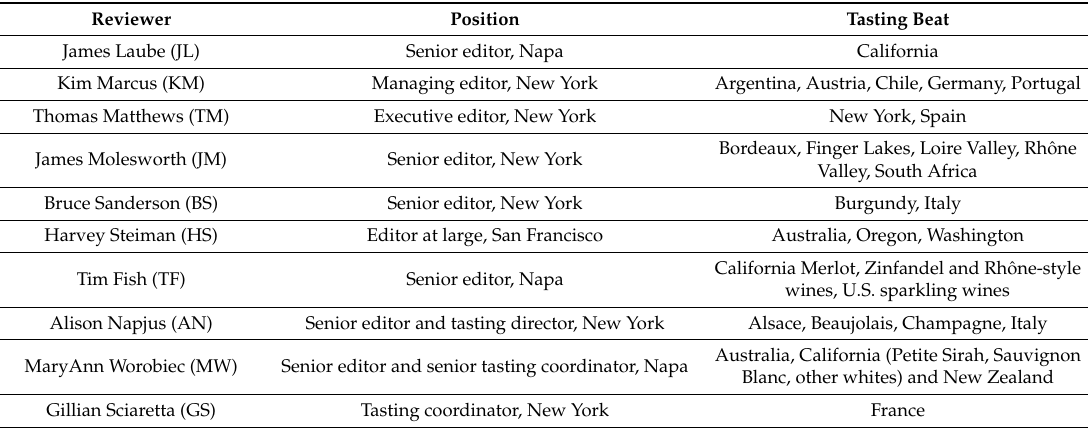
Table 3. Wine Spectator reviewer